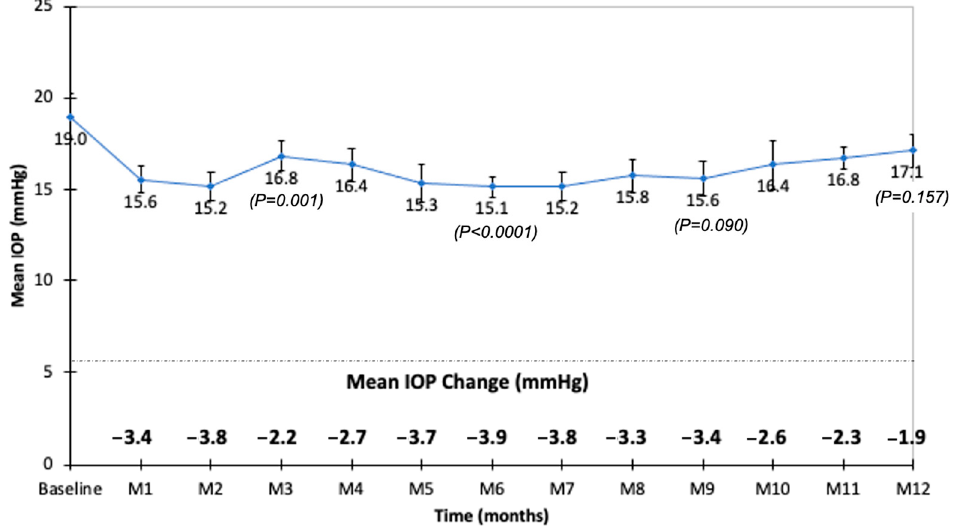
Figure 5. Mean intraocular pressure (IOP) and mean change in IOP during the follow-up after fluocinolone acetonide intravitreal injection.